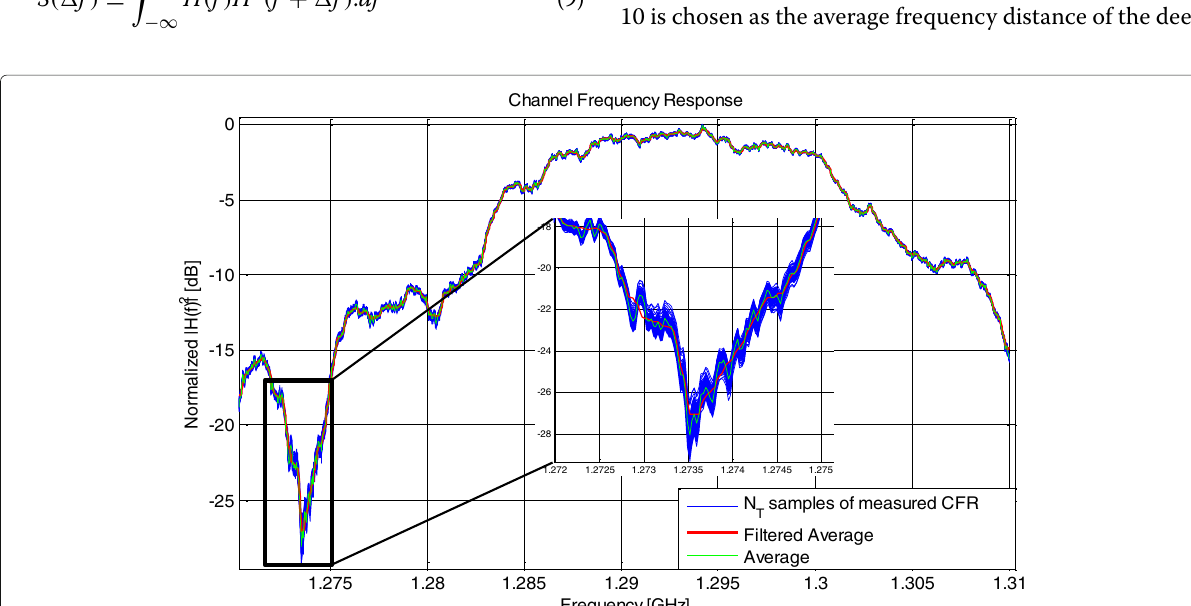
(cid:8) (cid:8) (cid:8) H ( f ) (cid:8) 2 used to characterize the channel frequency response. The blue curve represents N Fig. 5 Normalized response during 8 s. The green curve represents the average value of the measured channel responses. The red curve depicts the smoothed version of channel frequency response after applying the median